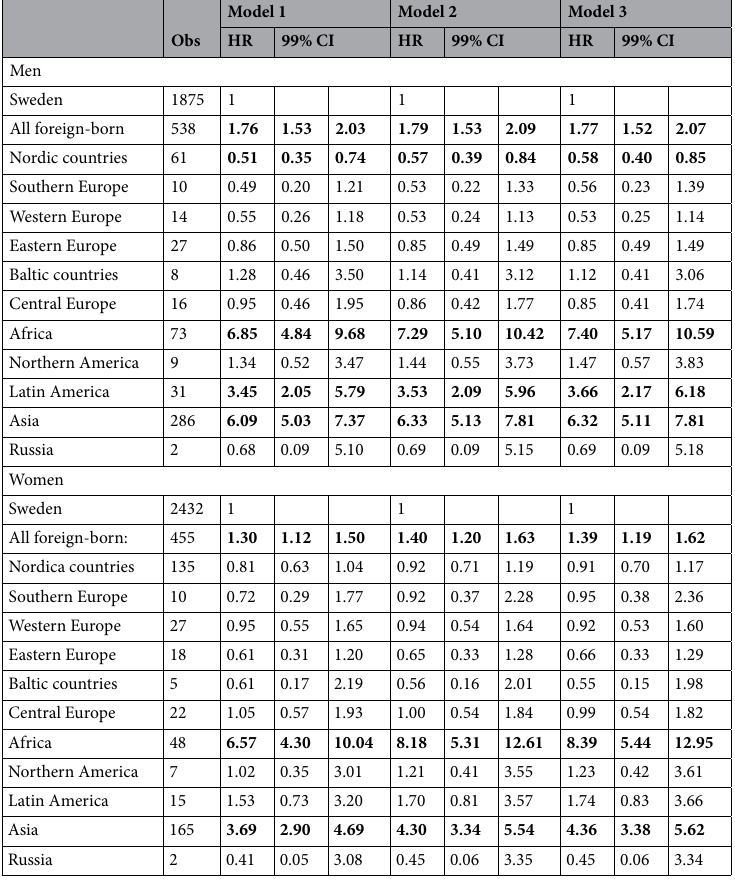
Table 3. The relative risk of post-polio in immigrants vs Swedish-born individuals expressed as hazard ratios (HRs) with 99% confidence intervals (99% CI). Bold values denotes statistically significant values. Model 1: adjusted for age and region of residence in Sweden; model 2: adjusted for age, region of residence in Sweden, educational level, marital status, and neighobrhood deprivations; model 3: model 2 +